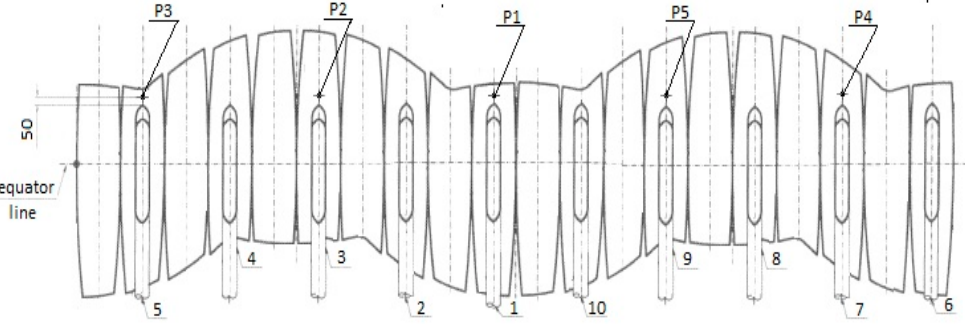
Figure 5. The plan for the resistive strain sensor positions.